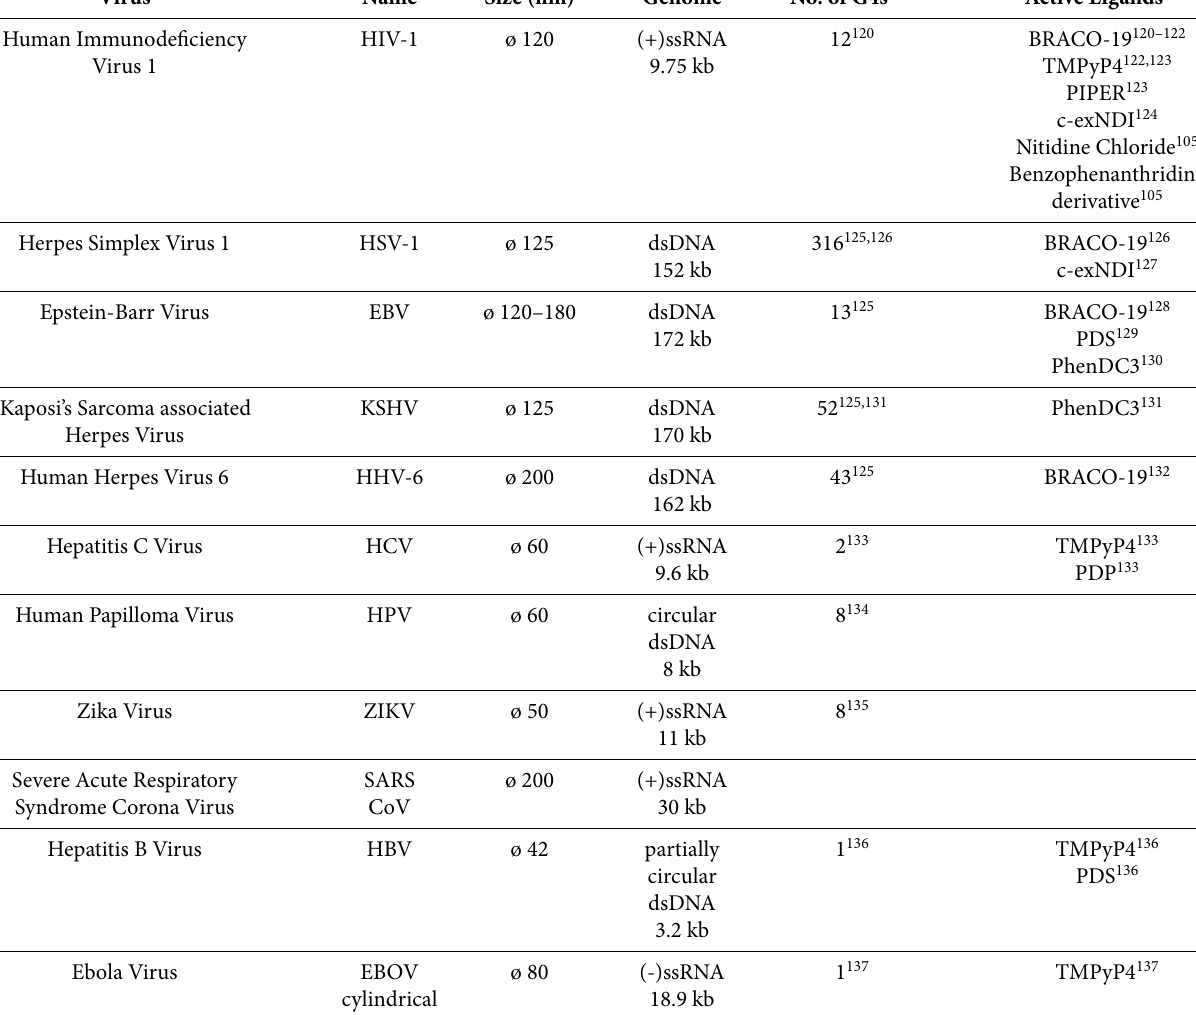
Table 2. G4s that are identified in viral genomes and their active ligands. Updated data reported previously. 46